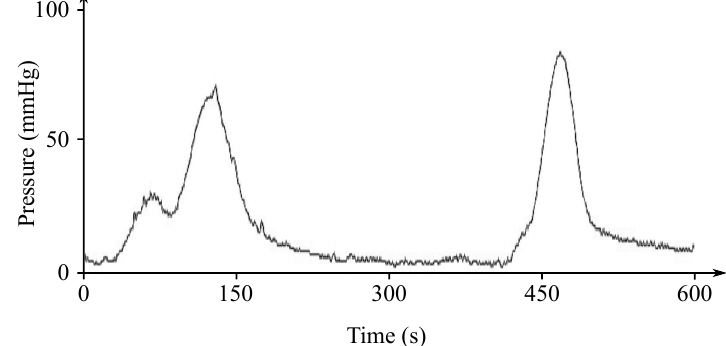
Figure 13. Plot of a recorded IUCP